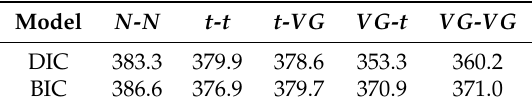
Table 1. Deviance information criterion (DIC) and Bayesian information criterion (BIC) of stochastic volatility (SV) models with different error distributions. N - N : normal-normal; VG : variance gamma. Model N - N t - t t - VG VG - t VG - VG 383.3